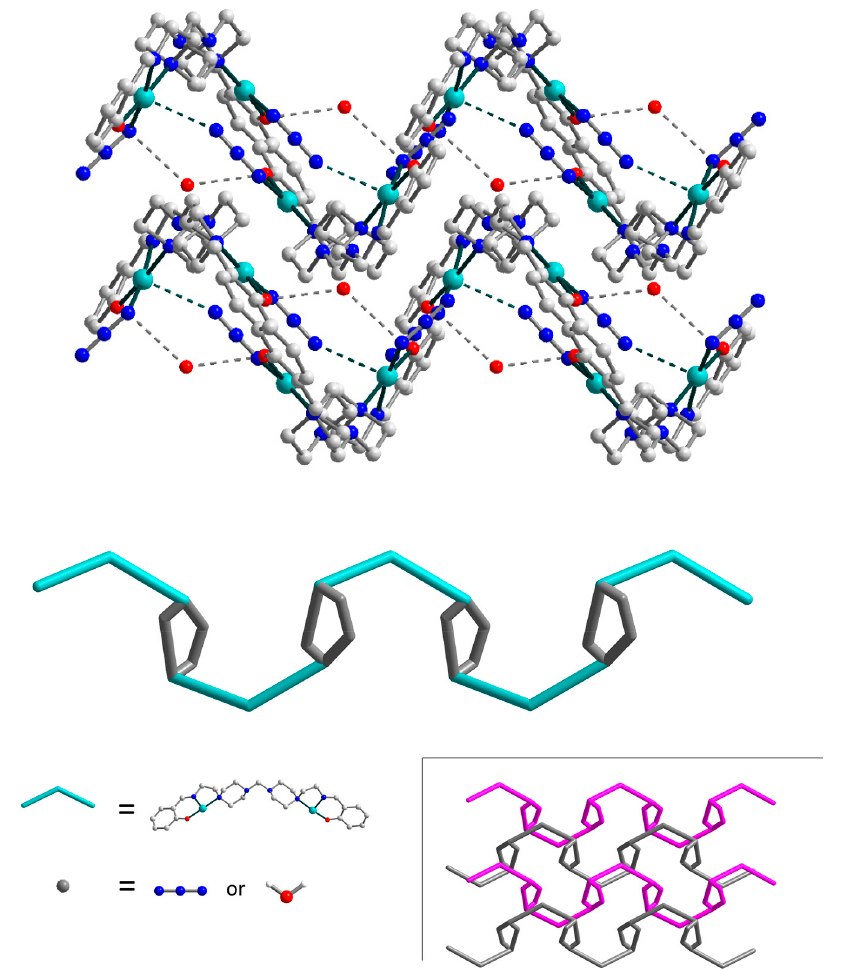
Figure 7. Top: packing of the supramolecular chains in 2 along the b axis. The hydrogen atoms are omitted for clarity. Bottom: simplified topology of 2 . Colour scheme: Cu, cyan; O, red; N, blue; C, grey. Table 2. Selected geometrical parameters (distances/Å and angles/°) for 1.